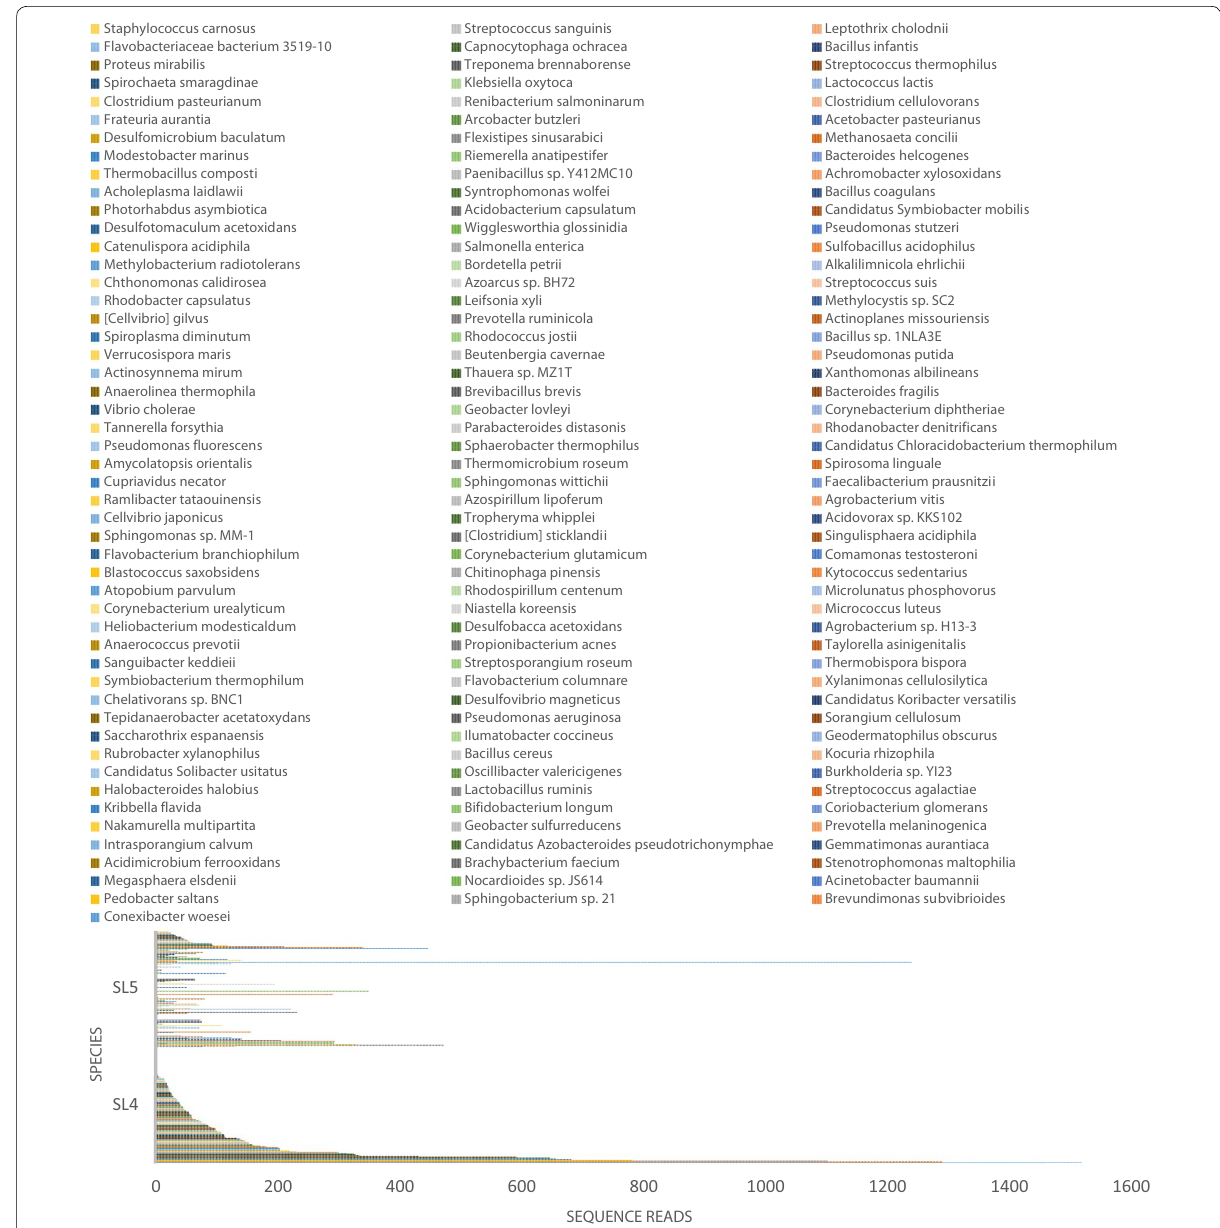
Fig. 4 Comparative taxonomic profile of SL4 and SL5 metagenomes at species level, computed by EDGE Bioinformatics. Unclassified reads were not used. Only species with 10 sequence reads were used for the ≥